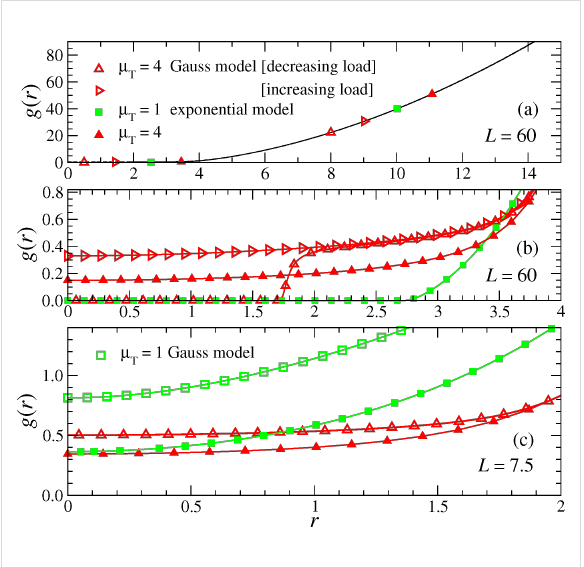
Figure 19: Gap g ( r ) as a function of the lateral distance from the origin r for a large load F N = 60 (a) and (b) as well as for an intermediate load F N = 7.5 (c). In each case, surfaces repel each other. Graph (b) contains the same data as (a) but has higher resolution. Color coding: μ T = 4 (red) and μ T = 1